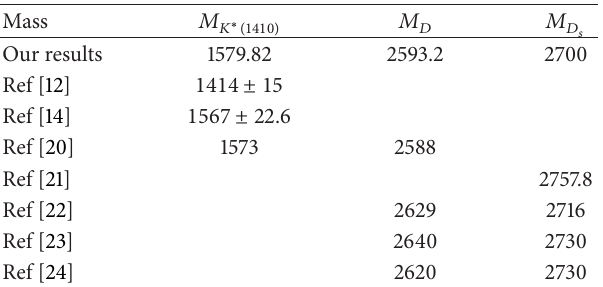
Table 3: Masses (MeV) of 𝐾 ∗ (1410) , 𝜙(1680) , and 𝜓(2𝑆) in the 2 3 𝑆 1 meson